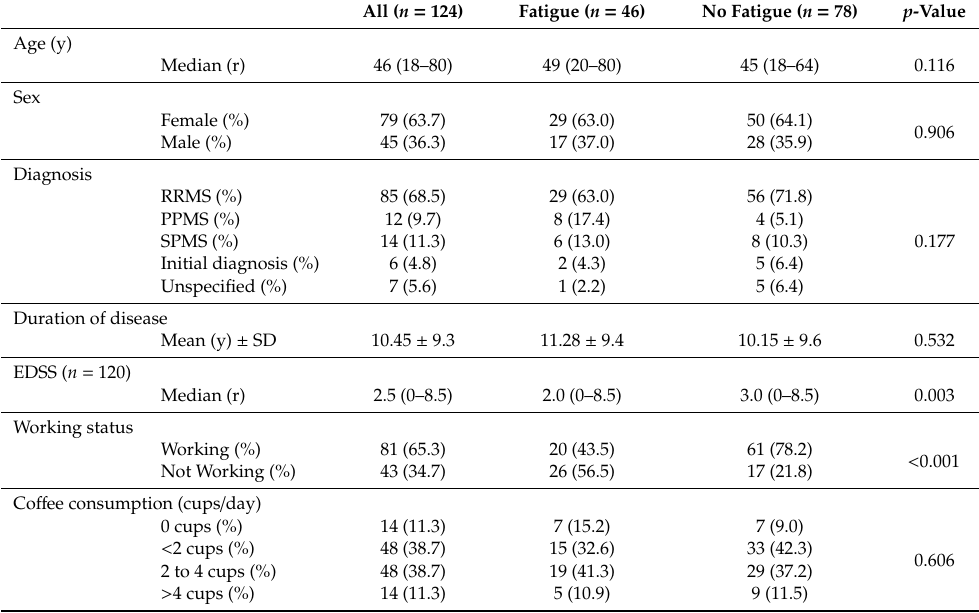
Table 1. Patient characteristics.